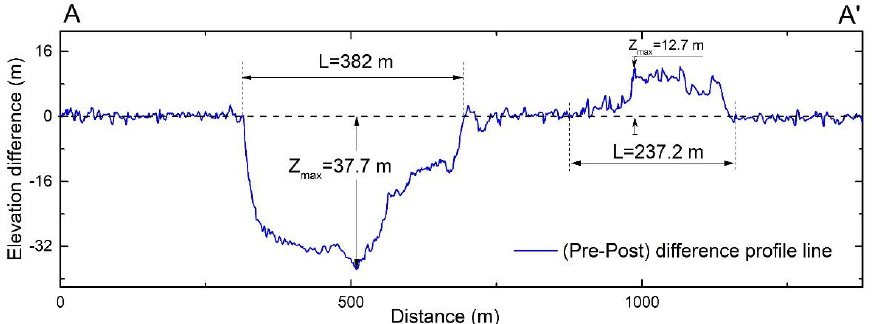
Figure 16. Elevation difference along the cross-section line A-A’ obtained from (pre-post) DEMs. In addition to that, the volumes of the displaced materials were also estimated for the uncorrected DEMs and summarized in Table 3. The total erosion volume of 1.61 × 10 6 m 3 was approximately 53% larger than the one estimated from the corrected DEMs. The total deposition volume in the uncorrected DEM is 54% larger than that of the adjusted DEMs. The percentage increase between the corrected and uncorrected DoDs in the ero- sion and deposition zones was also summarized in Table 3. From the percentage increase, clearly, one can appreciate that the estimated parameters (volumes and depths) in the un- corrected DoD were significantly more extensive than that of the correct one. This implies that applying the proposed method considerably decreases the estimated volume of the soil. Furthermore, it reveals that the direct use of DoD without correcting the errors, leads to the overestimation of the landslide volume. Table 3. Summarized erosion and deposition volumes for the corrected and uncorrected DoD. Corrected A Erosion